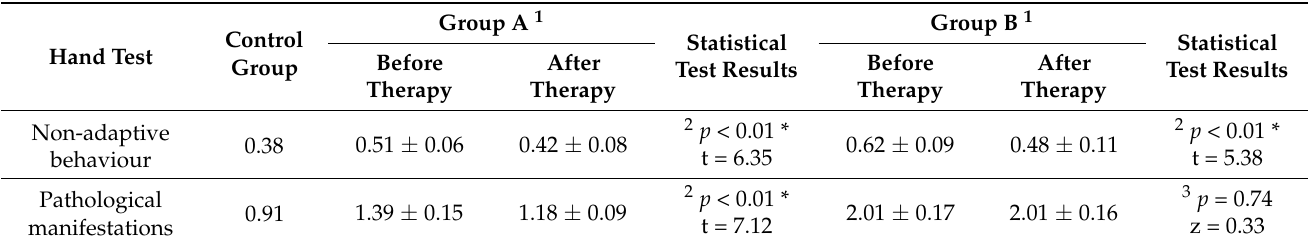
1 Values represent the arithmetic mean ± standard deviation. 2 T -test for dependent samples ( α = 5%). 3 Wilcoxon matched pairs test ( α = 5%). Both tests were used to detect statistically significant differences before and after the experimental intervention. The * character means a statistically significant difference.